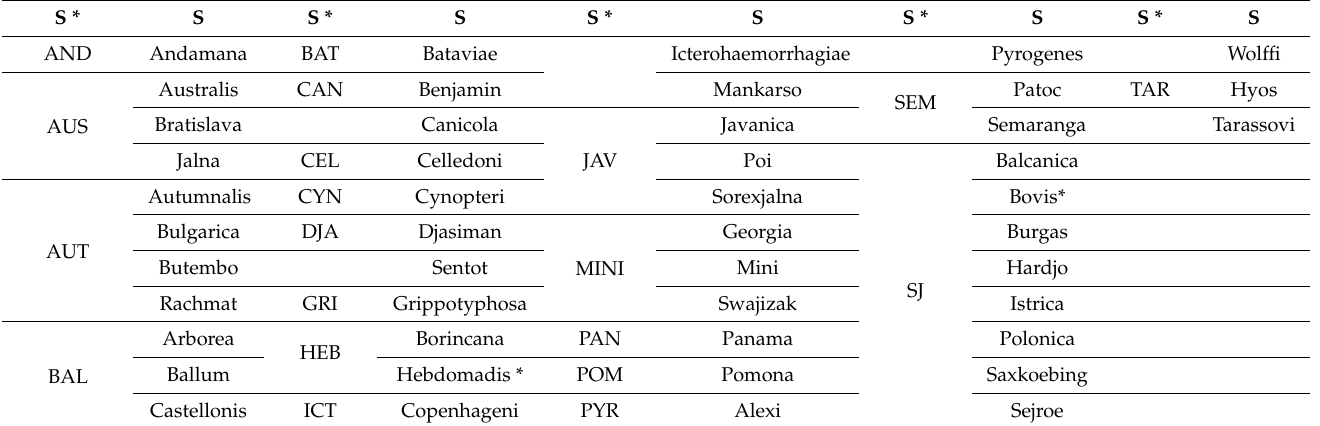
Table 5. Reference serogroups and serovars in the Middle